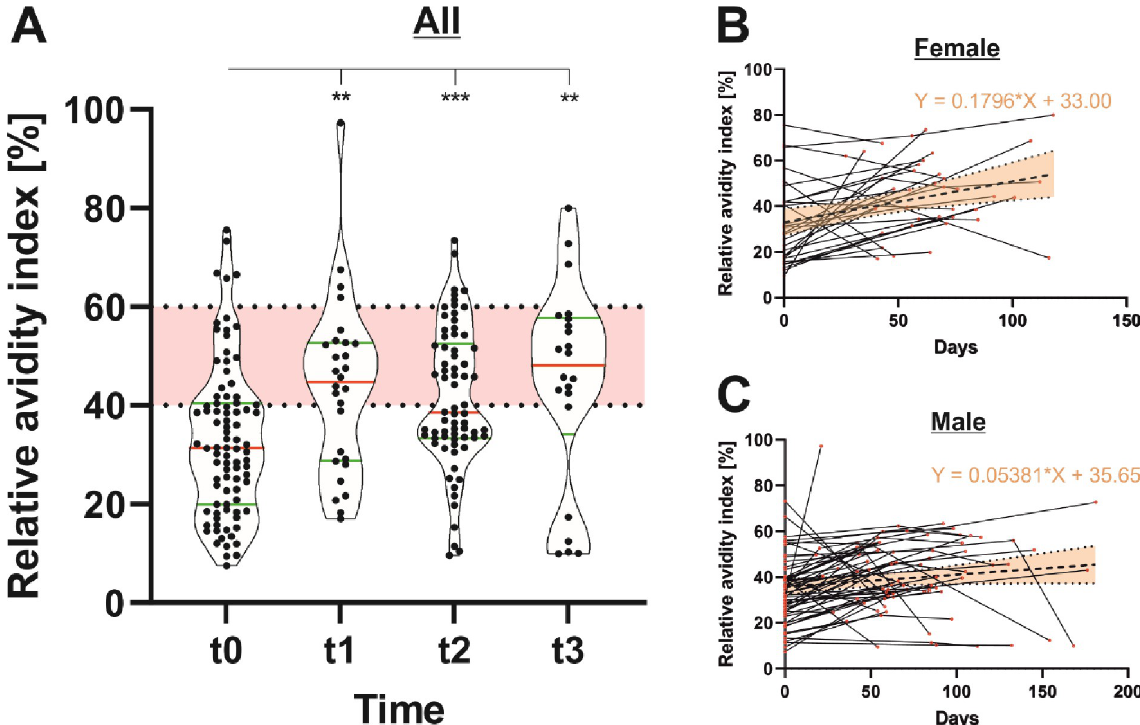
Fig 5. Persistence of anti-SARS-CoV-2 antibody avidity (n = 88). The avidity of anti-SARS-CoV-2 IgG antibodies was determined at different time points (t0 = initial seropositivity, t1 = up to 50 days after initial seropositivity, t2 = 50–100 days after initial seropositivity and t3 = 100–200 days after initial seropositivity) using an assay from Euroimmun (A). Considering regression line slopes, antibody avidity increased more strongly in female (B) compared to male (C) blood